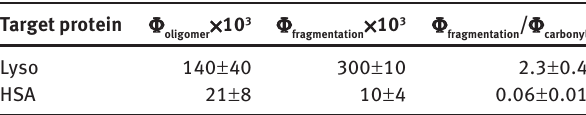
Table 1 Quantum yields ( Φ ) of lysozyme and HSA modifications elicited by AAPH-derived peroxyl radicals.